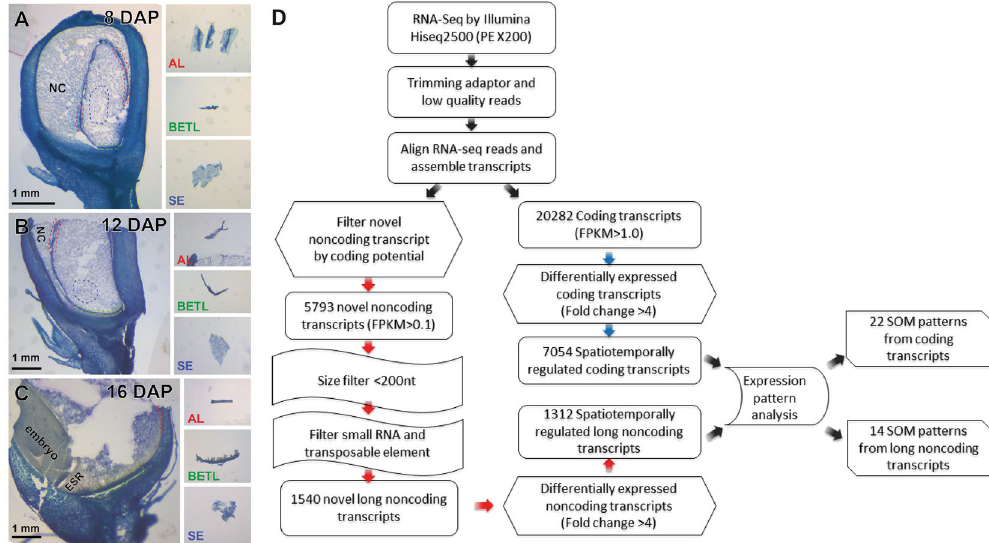
Figure 1. Schematic of method for transcriptome analysis of developing maize endosperm. ( A – C ) HistoGene- stained frozen sections from kernels at ( A ) 8 DAP, ( B ) 12 DAP, and ( C ) 16 DAP. Three insets on the right side of each panel show the three tissue types isolated from cryo-sections by free-hand dissection. The tissues surrounded by the red dashed lines and the blue dashed lines correspond to the AL and SE tissue, respectively. The BETL is marked with green dashed lines. NC, nucellus. ( D ) The bioinformatics pipeline used to identify spatio-temporally regulated coding and long noncoding transcripts at three stages of the maize endosperm